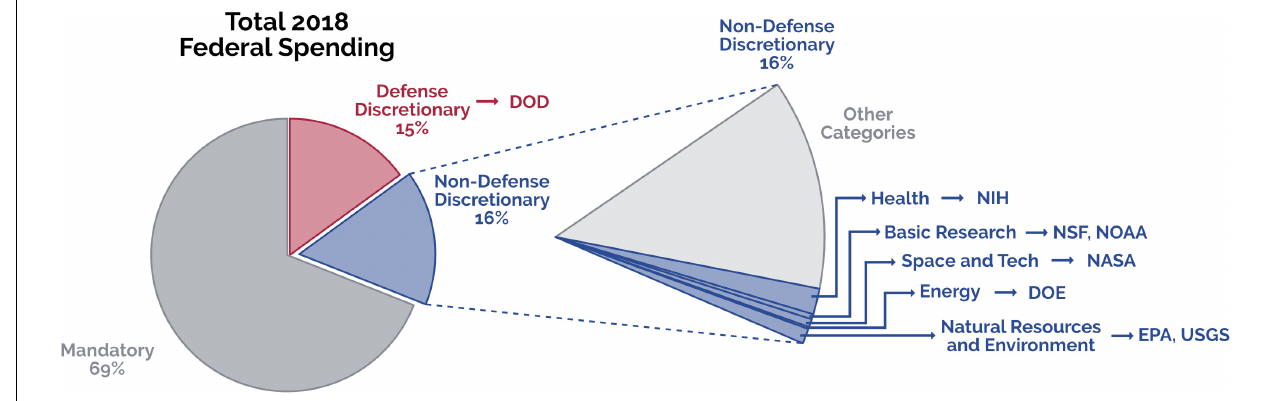
FIGURE 3 | Proportions of fiscal year 2018 federal spending, highlighting scientific research and agencies nested within the overall budget. Government spending is broadly divided between mandatory (gray) and discretionary expenses (blue and red). Mandatory expenses are largely determined by the White House Office of Management and Budget (OMB) and are inflexible. Appropriations bills are required to set discretionary spending. Non-defense discretionary spending (blue) is more flexible and supports a large portion of scientific research within the United States and is decided by appropriations bills in Congress. Arrows indicate some of the agencies that are funded through each category; Department of Defense (DOD), National Institute of Health (NIH), National Science Foundation (NSF), National Oceanic and Atmospheric Administration (NOAA), National Aeronautics and Space Administration (NASA), Environmental Protection Agency (EPA), United States Geologic Survey